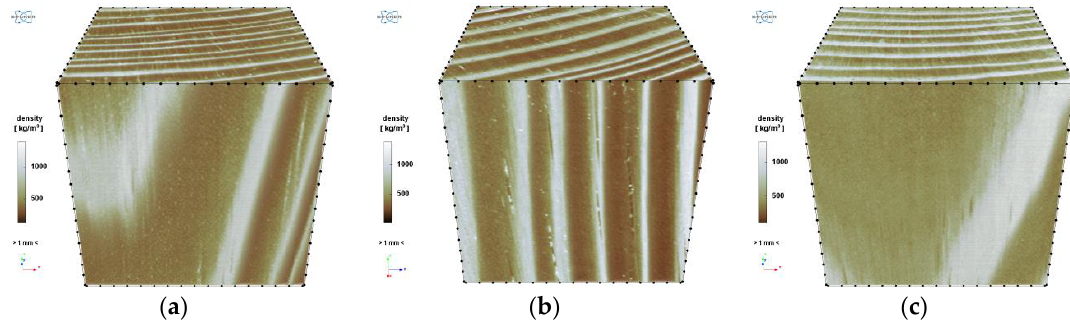
Figure 17. Spatial distribution of density: ( a ) “1”; ( b ) “2” and ( c ) “3”.